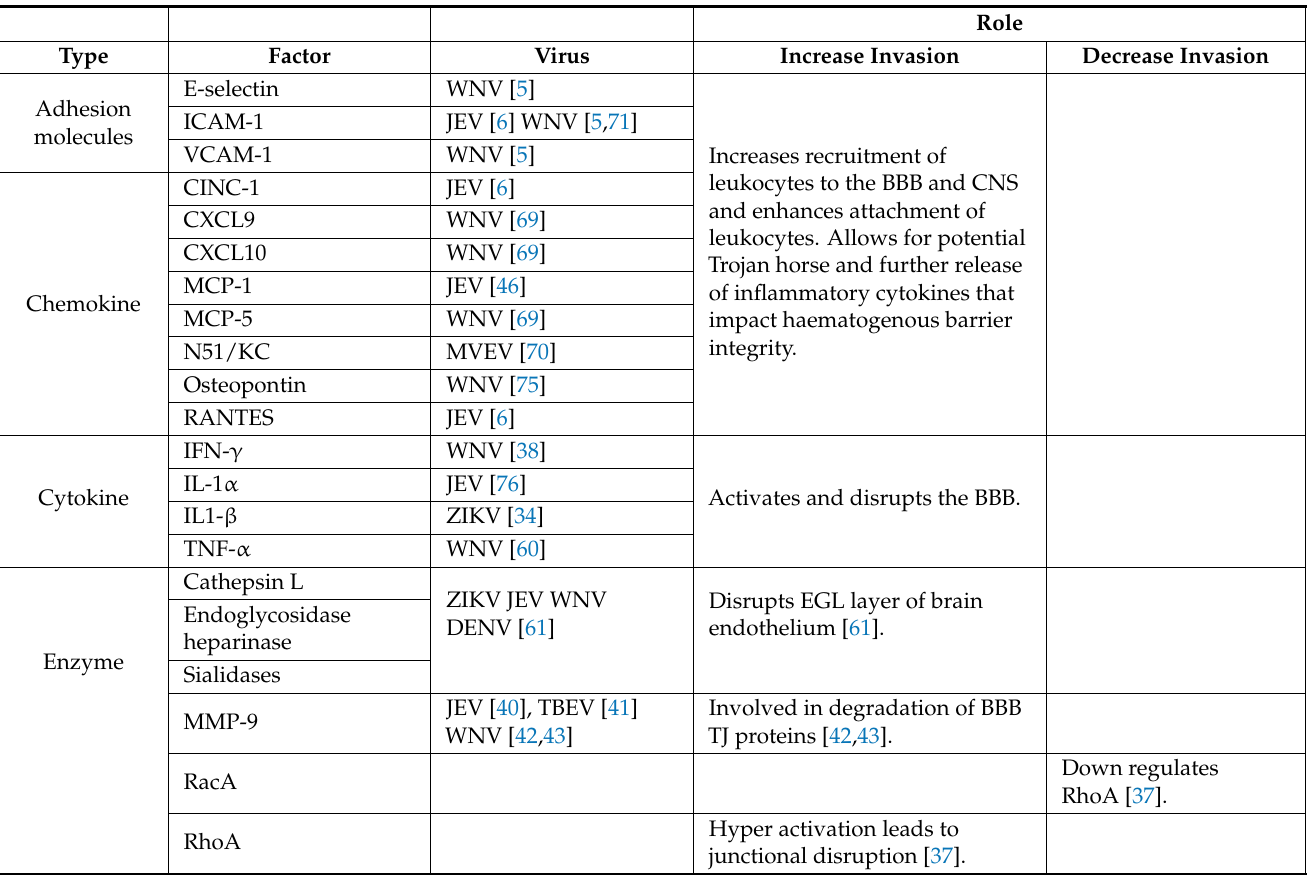
Table 2. Summary of the host factors discussed in this review and their contribution to the initial invasion of the CNS by